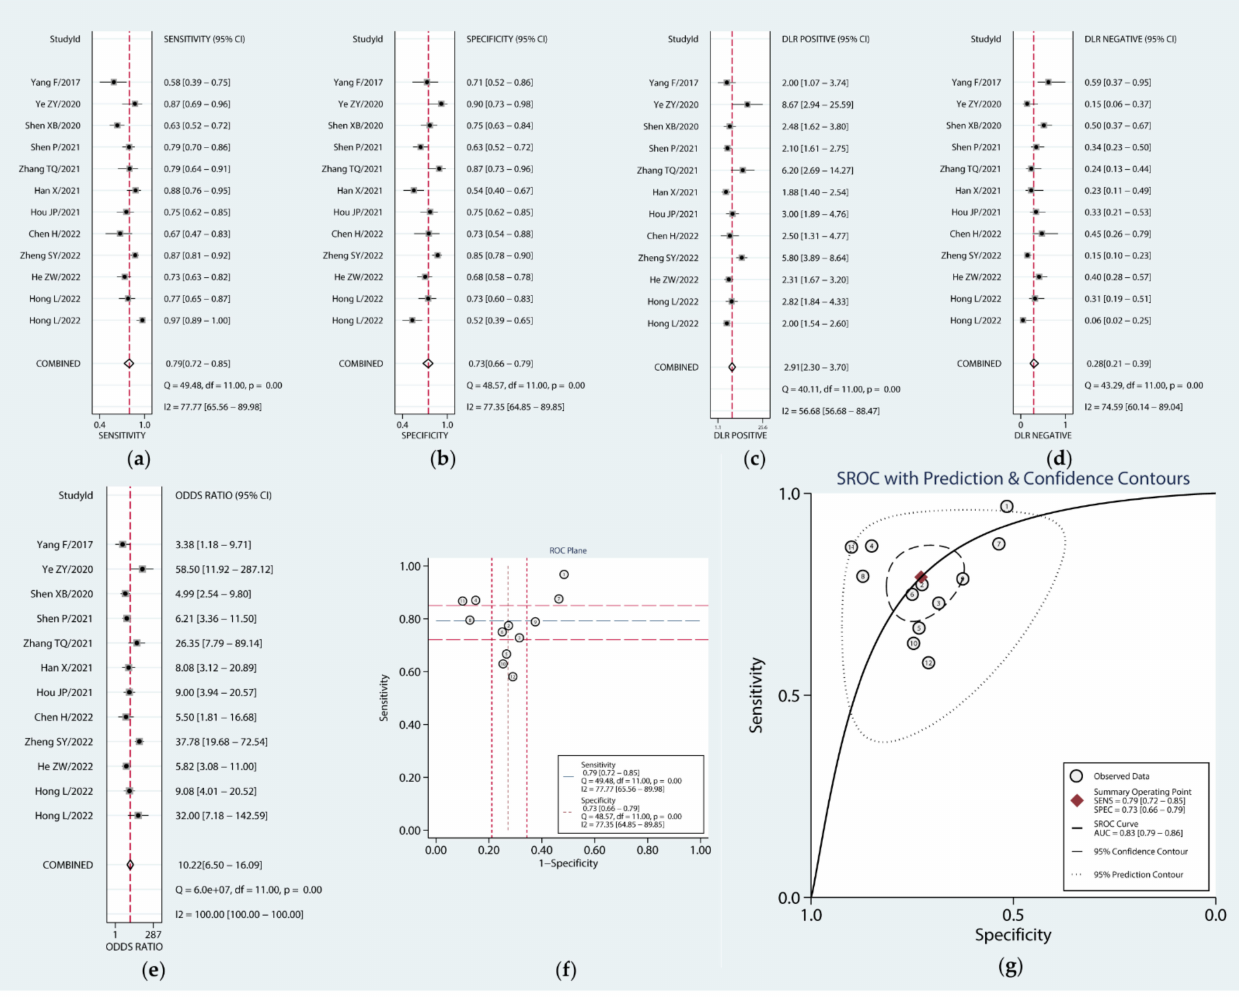
Figure 3. Forest plots of the combined sensitivity ( a ), specificity ( b ), PLR ( c ), NLR ( d ), DOR ( e ), ROC plane ( f ), and SROC curve ( g ) to illustrate the diagnostic value of circRNAs in pancreatic